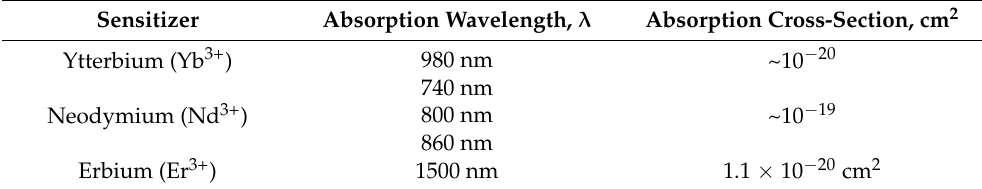
Table 2. Common lanthanide sensitizers and their absorption cross-sections